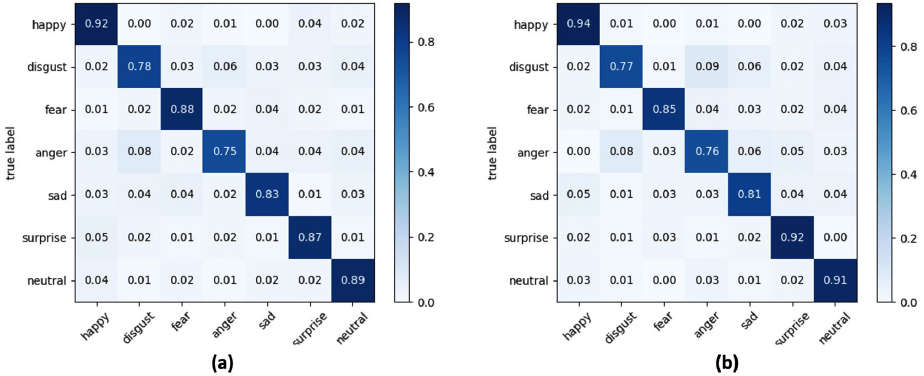
Figure 9. Confusion matrix for seven classes of facial expressions using SVM as classifier and at varying of ( a ) yaw angle and ( b ) pitch angle.